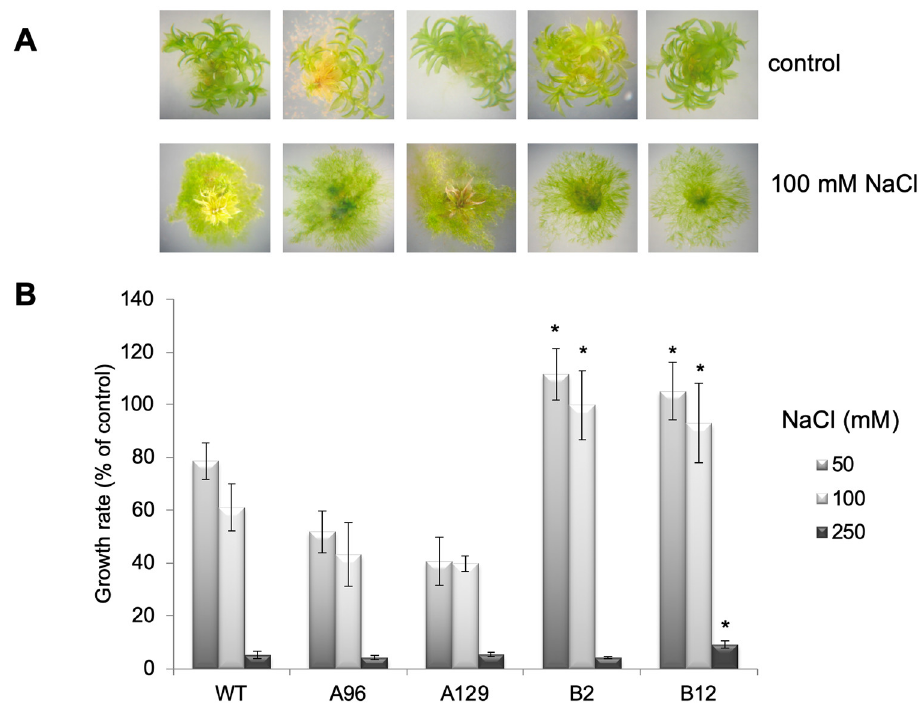
Figure 4. Growth of protonema is promoted on high salt concentrations, which results in accelerated growth rates: ( A ) Examples of WT and GH3 double KO lines on control medium and medium containing 100 mM NaCl; ( B ) The growth rate of the same lines on 50, 100, and 250 mM NaCl determined as percent of the control without NaCl over the time of 50 days after transfer to salt-containing medium. The asterisks indicate significant differences between WT and mutant lines at p < 0.05.